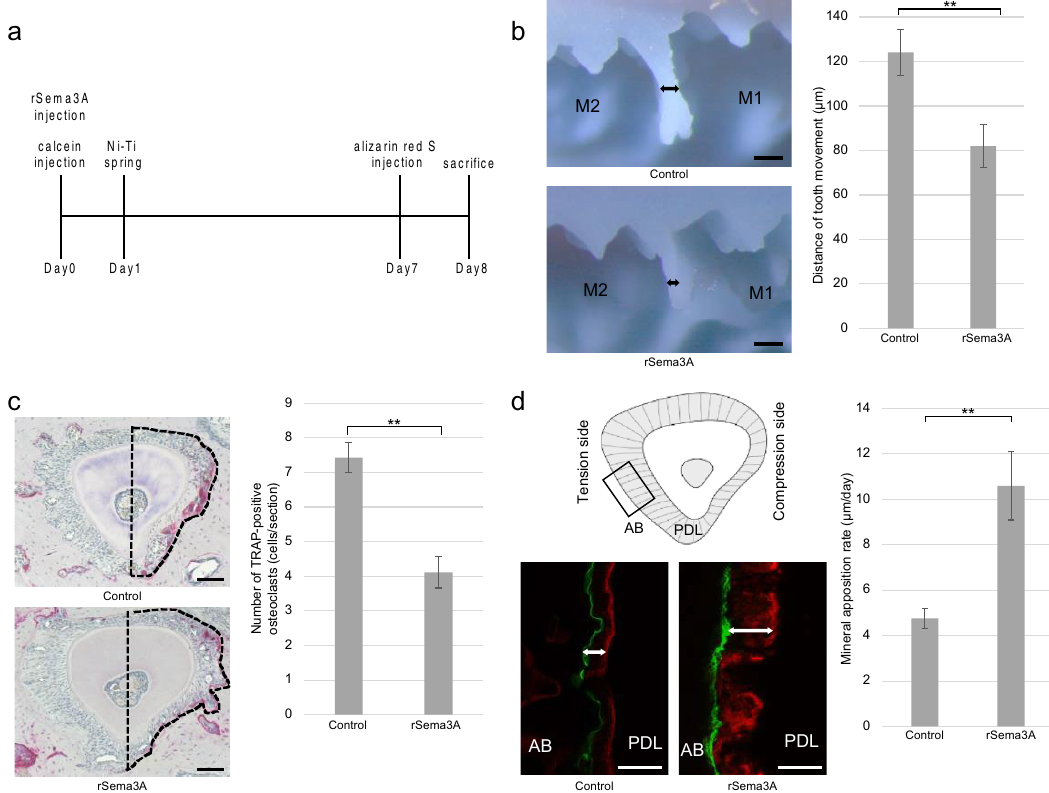
Figure 3. ( a ) Schematic diagram of rSema3A, calcein, and alizarin red S injection time course. rSema3A and calcein were injected 1 day before Ni–Ti coil spring attachment. Alizarin red S was injected 1 day before sacrifice. ( b ) Distance of tooth movement. Black arrows on the impression show orthodontic tooth movement (OTM) distance of the rSema3A injection group and control group on day 7. OTM distance in the rSema3A injection group was significantly reduced compared to that in the control group (n = 5). M1, first molar; M2, second molar. Scale bars = 200 µm. ( c ) Tartrate-resistant acid phosphatase (TRAP) staining and number of TRAP-positive osteoclasts (n = 4). The dotted line shows the compression side of the palatal root. The number of osteoclasts in the rSema3A injection group was significantly reduced compared to that in the control group. Scale bars = 50 µm. ( d ) Double-fluorescence bone labeling and mineral apposition rate of the control and rSema3A injection groups (n = 3). Black square area of schematic diagram is magnified. Alizarin red S bone labels are shown as red lines, and calcein bone labels are shown as green lines. White arrows indicate the mineralized distance after OTM. The mineral apposition rate in the rSema3A injection group was significantly increased compared to the control group. AB, alveolar bone; PDL, periodontal ligament. Scale bars = 50 µm. Data are presented as mean ± SD. * p < 0.05 and ** p <